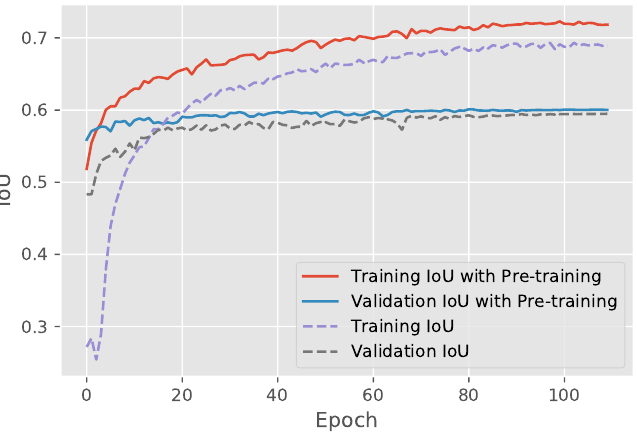
Figure 5. Comparison of the model with pre-training and with random initialization. The figure plots the learning curves of the base model f 1 . We can observe that f 1 with pre-training on f 0 converges faster and leads to better